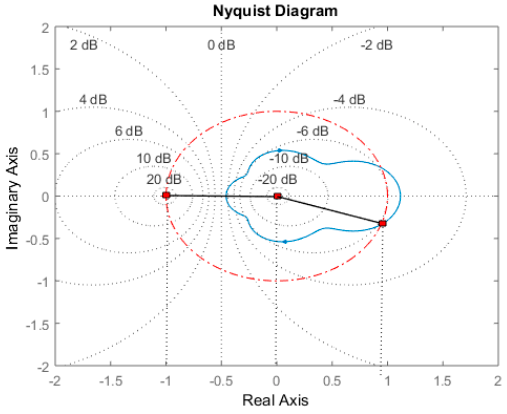
Figure 17. The complex plane characteristic of the control system—Nyquist diagram.